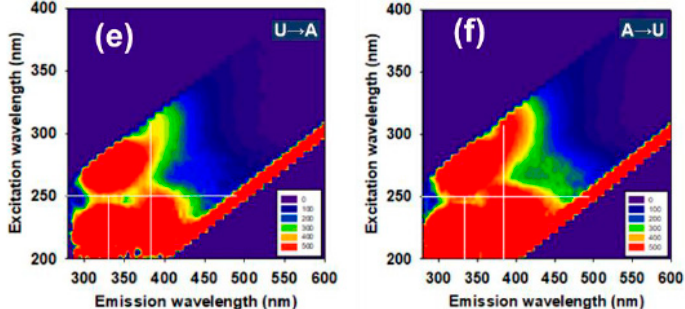
Figure 1. Excitation-emission matrix spectrum for the filtrate obtained from waste-activated sludge (WAS) pretreated by ( a ) alkaline → thermal (A → T), ( b ) thermal → alkaline (T → A), ( c ) thermal → ultrasonic (T → U), ( d ) ultrasonic → thermal (U → T), ( e ) ultrasonic → alkaline (U → A), and ( f ) alkaline → ultrasonic (A → U) pretreatments.